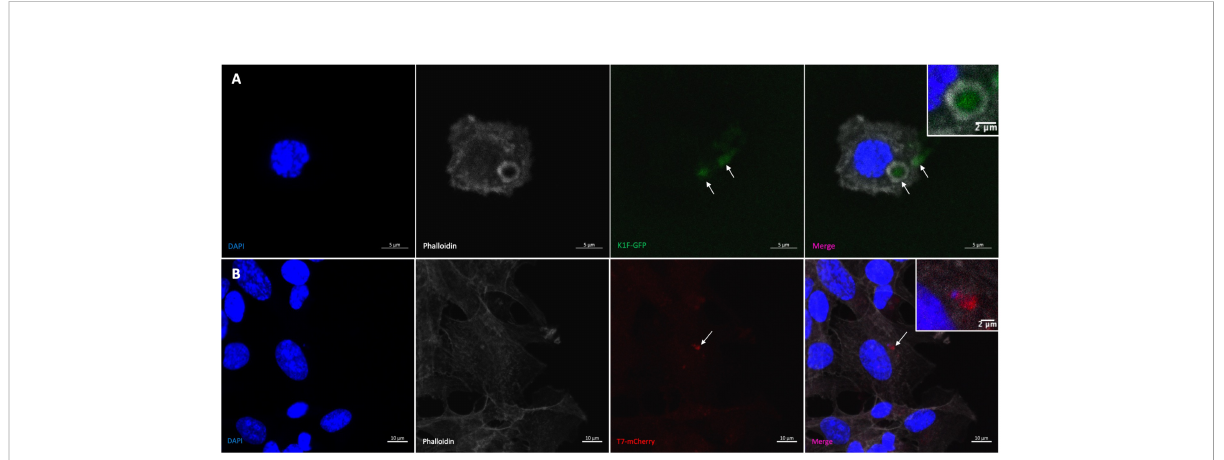
FIGURE 2 Visualising bacteriophage in hCMEC brain cells. (A) K1F-GFP phage inside vacuole of hCMEC cell after infection. (B) T7-mCherry phage inside hCMECs after infection. Arrows pointing to phage clusters. DAPI stain is shown in blue, phalloidin stain is shown in grey, K1F-GFP is shown in green, and T7-mCherry is shown in